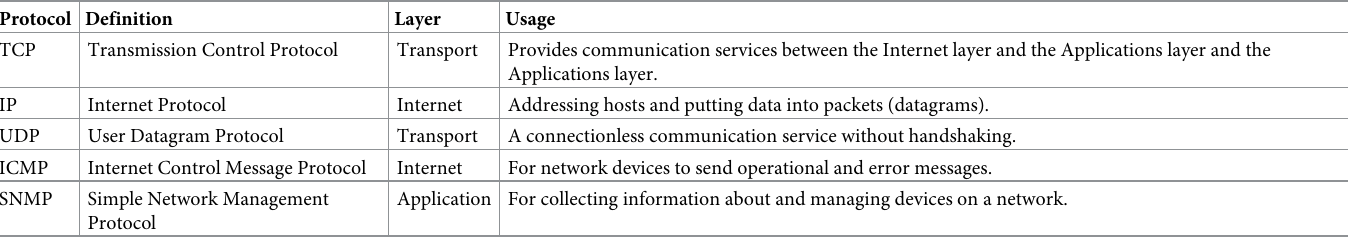
Table 1. Some network traffic